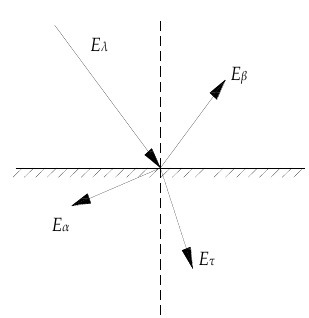
Figure 8. The absorption, reflection, and transmission of heat radiation from pavement.